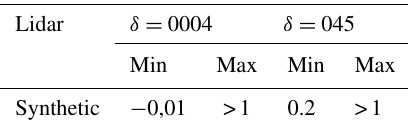
Table 3. Minima and maxima of the simulated volume linear depo- larization ratio, δ , from the complete search applied to the synthetic